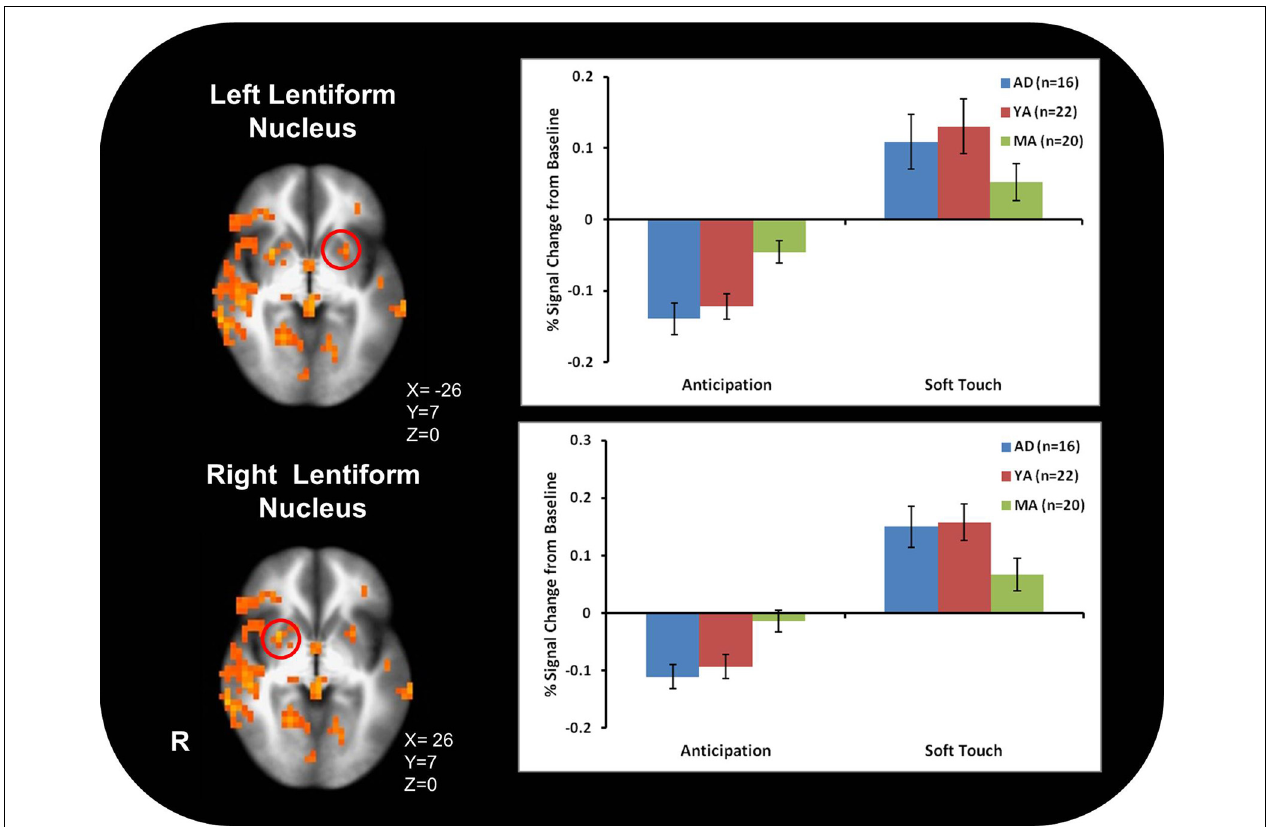
FIGURE 5 | In bilateral ventral striatum (Ientiform nucleus), mature adults (MA) showed greater activation than adolescents (AD) and young adults (YA) during anticipation. During the Soft touch condition (AI) and YA showed greater activation than MA in the right ventral striatum.